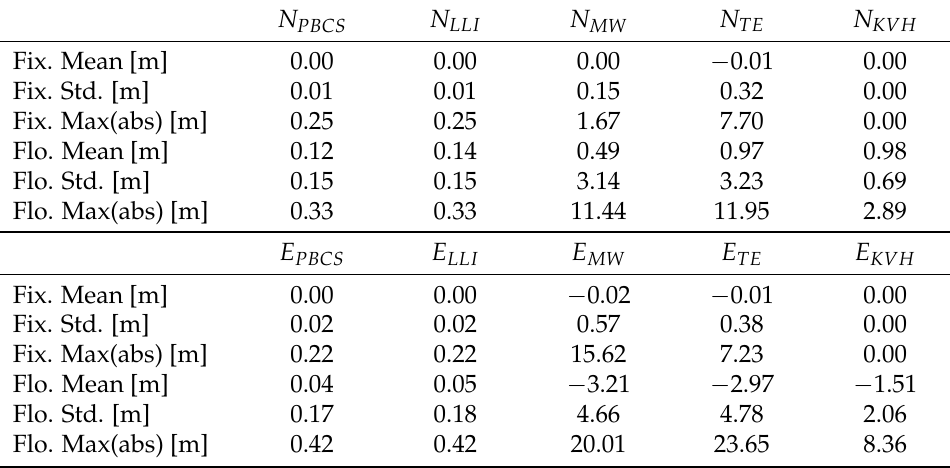
Table 7. Coordinate differences from u-blox moving base receiver—Case Study